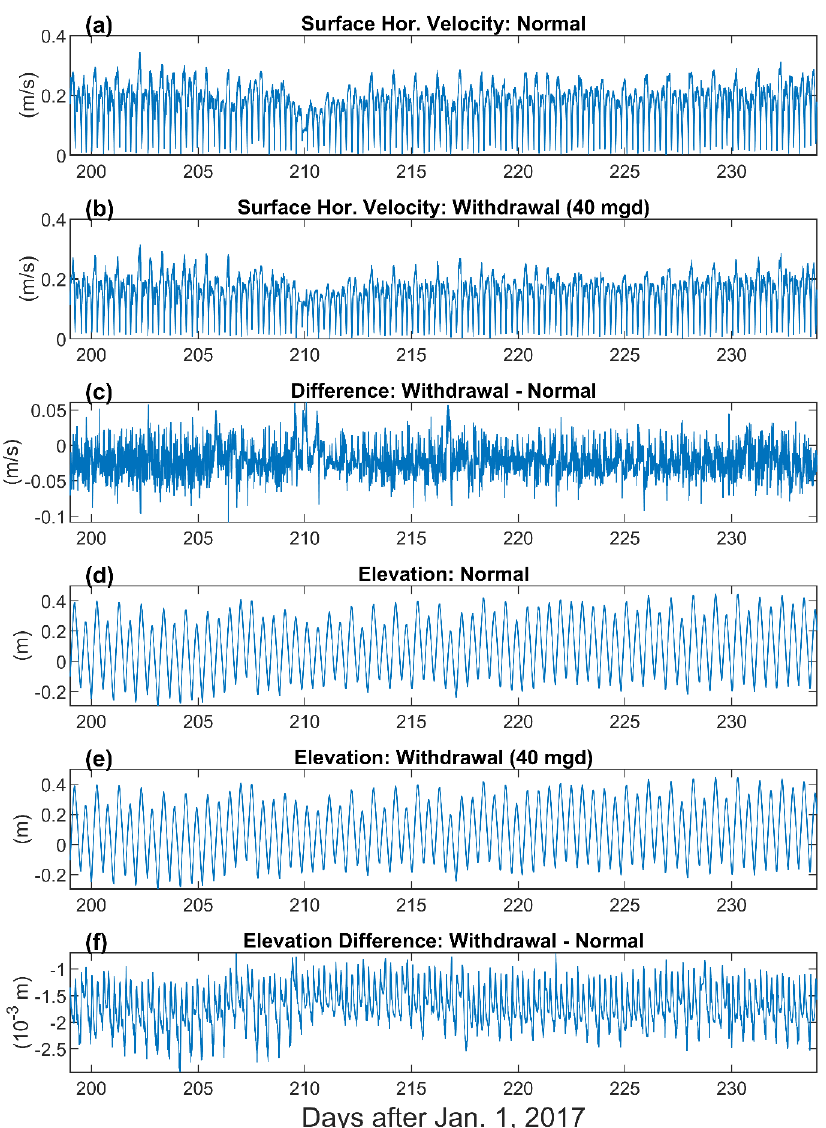
Figure 4. Time series of the speed of surface horizontal velocities ( a – c ) and elevation ( d – f ) at one location of the intake area under “Normal” (without the intake) and “Withdrawal” (with the intake) conditions and the difference between the two conditions.